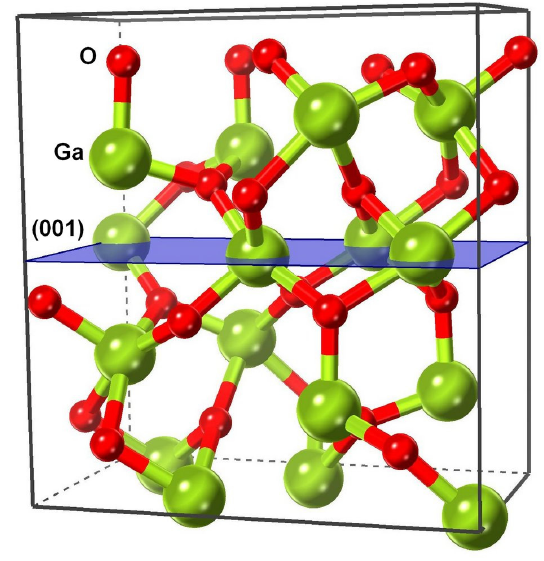
Figure 9. Configuration of atoms in ε -Ga 2 O 3 . The <001> axis is directed upwards. Large green balls represent Ga atoms; small red balls represent O atoms.